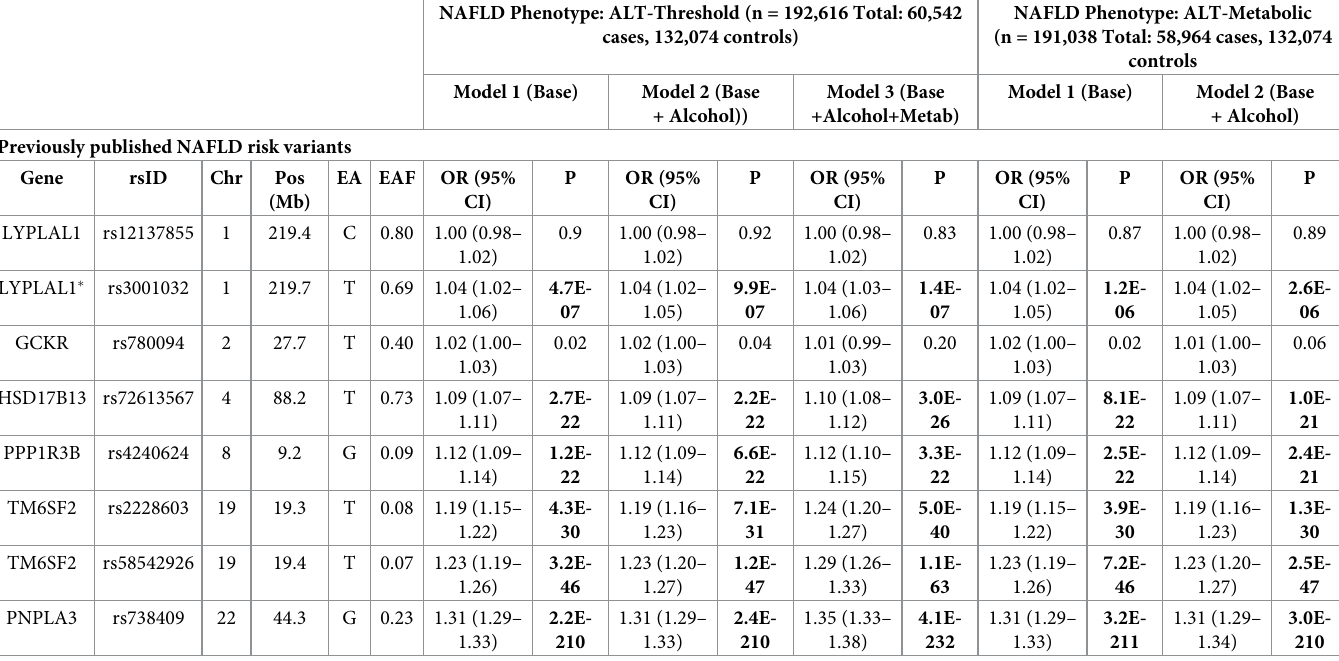
Table 2. Previously published NAFLD risk variants with genome-wide significant association with clinical NAFLD phenotypes across all ancestries in the Million Veteran Program NAFLD analytic